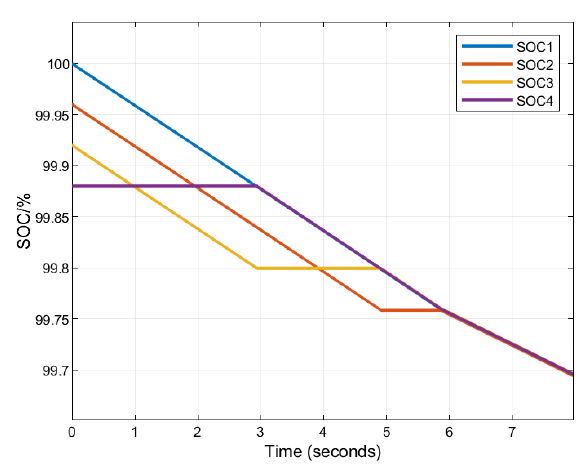
Figure 13. Equalization process of battery group 1.